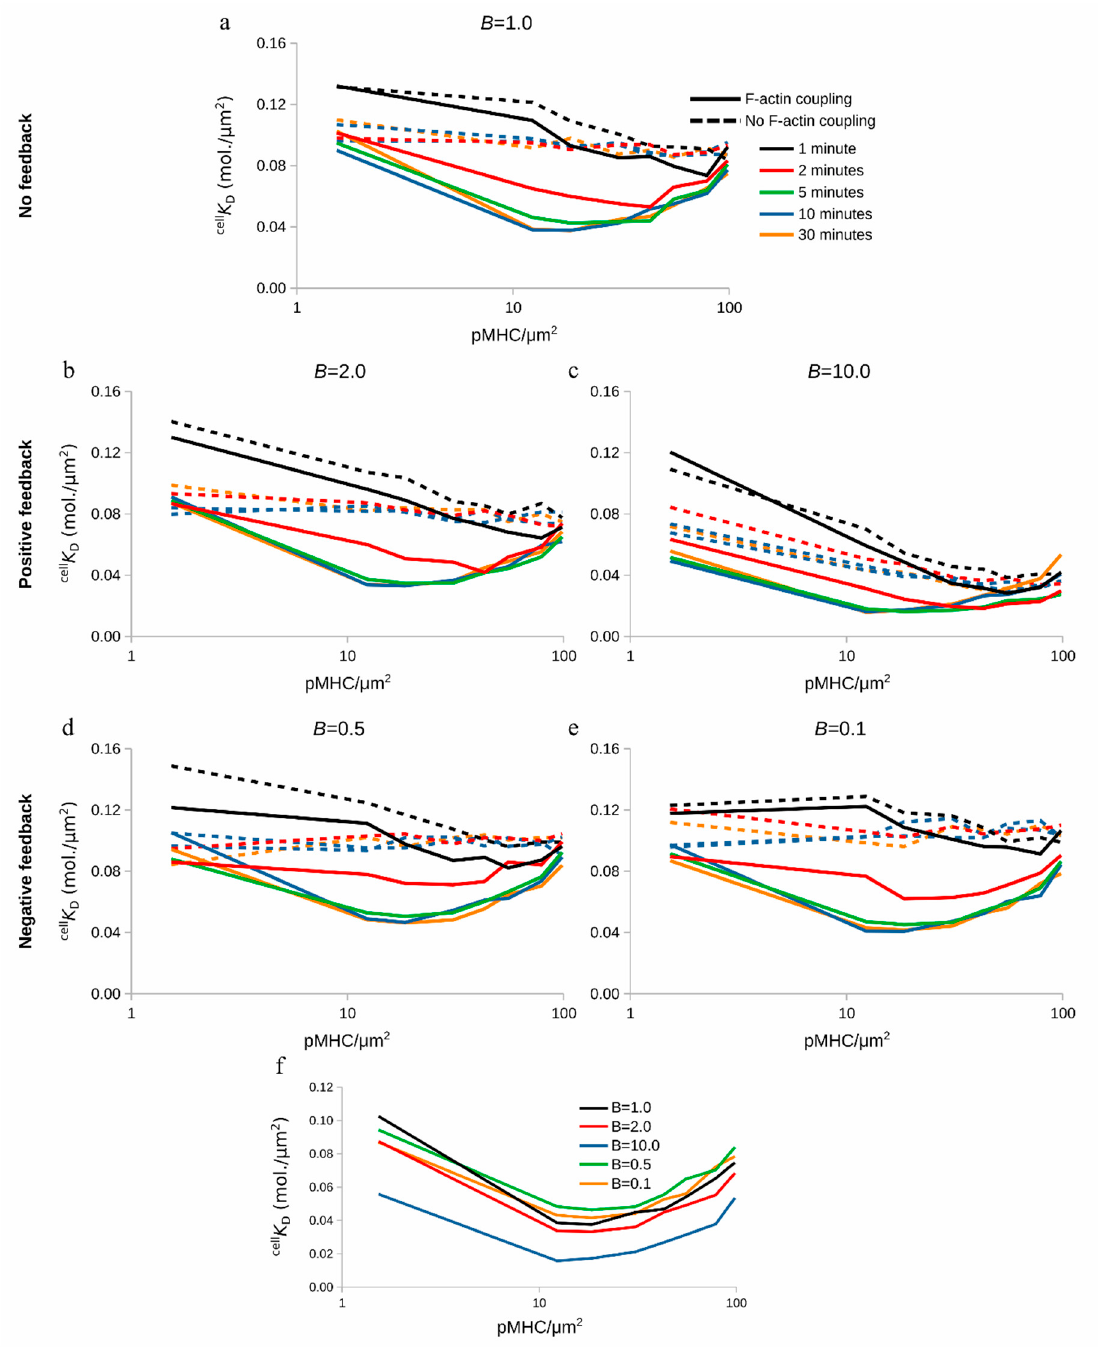
Figure 6. Effect of binding coefficient B on cell K D in the presence (solid line) or absence (dashed line) of centripetal transport of complexes: ( a ) control case with absence of feedback, ( b , c ) positive feedback from the F-actin foci, ( d , e ) negative feedback from the F-actin foci, and ( f ) comparison of positive and negative feedback with the control case, B = 1.0, at 10 min of IS formation.